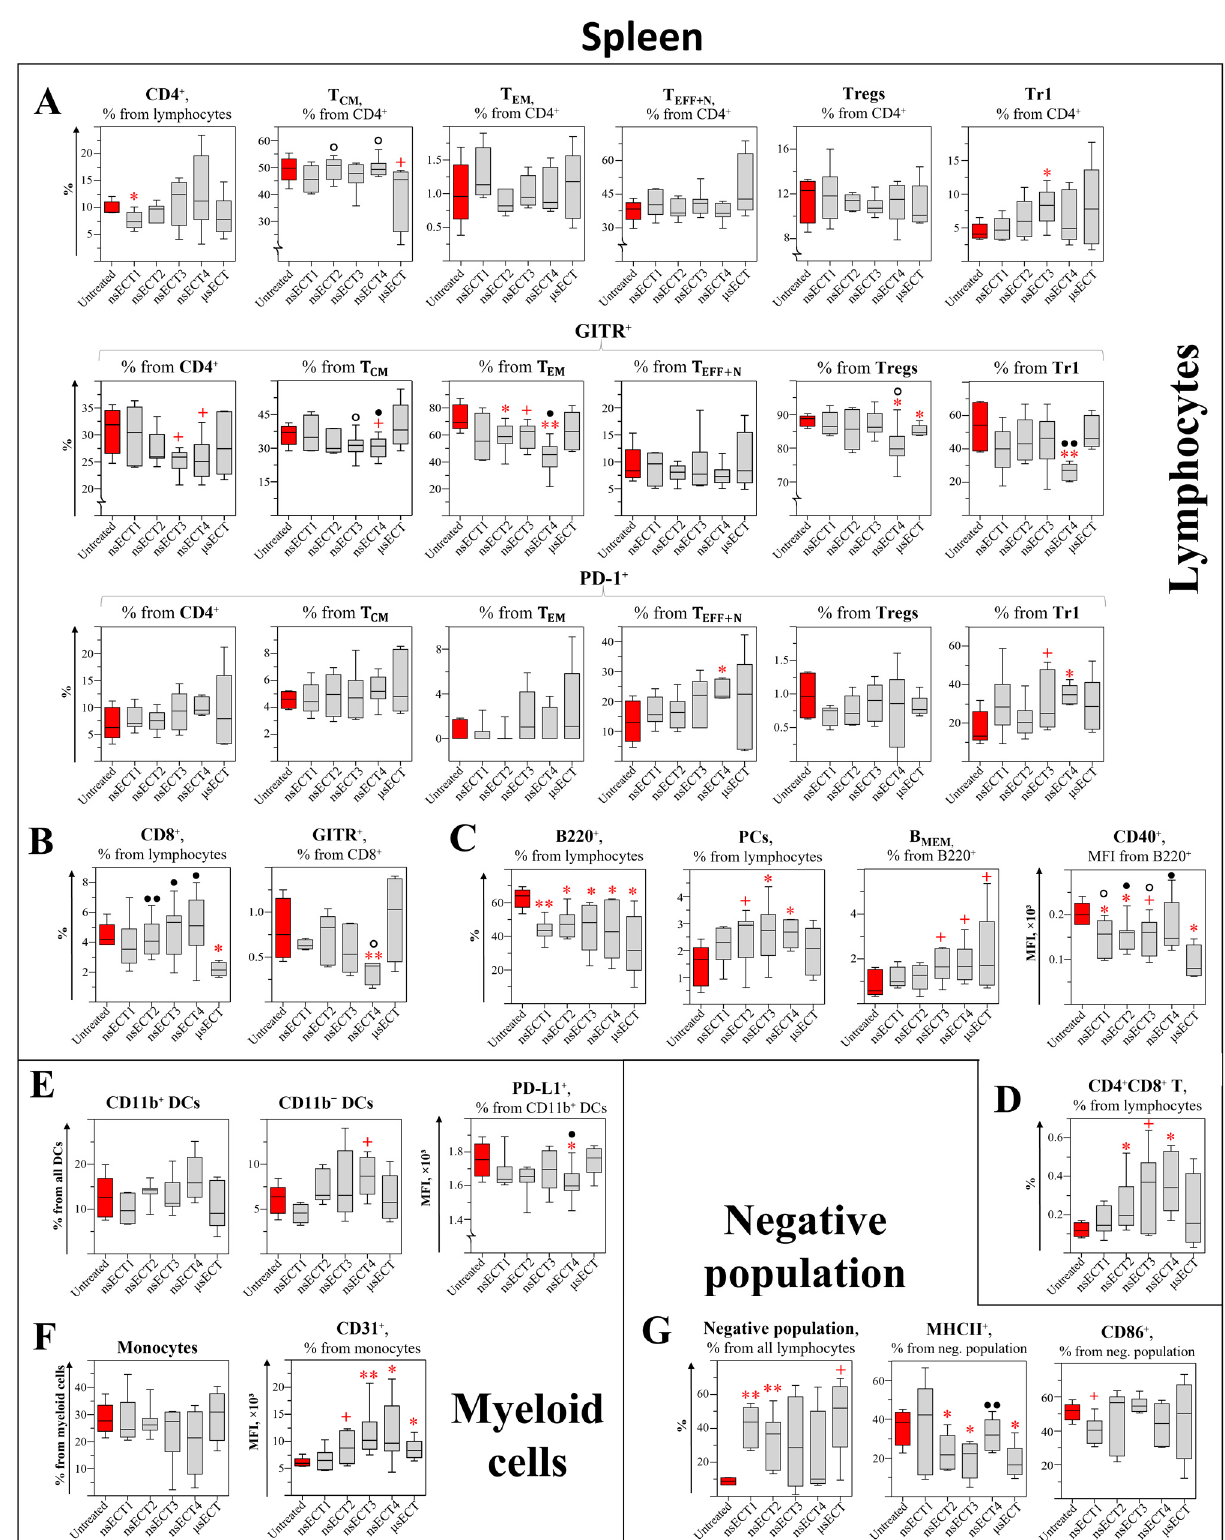
Figure 3. Time-dependent study. Lymphocyte ( A – D ), myeloid cells ( E , F ) and “Negative” (Lin ˉ ) population ( G ) in mice spleens. Cytometry was performed with BD FACSAria III cytometer. Statistically significant (* p < 0.05; ** p < 0.005) differences and tendencies (+ p = 0.05–0.1) compared to the untreated group. Significant differences ( ● p < 0.05; ●● p < 0.005) and tendencies ( 🇴 p = 0.05–0.1) compared to the μ sECT group.